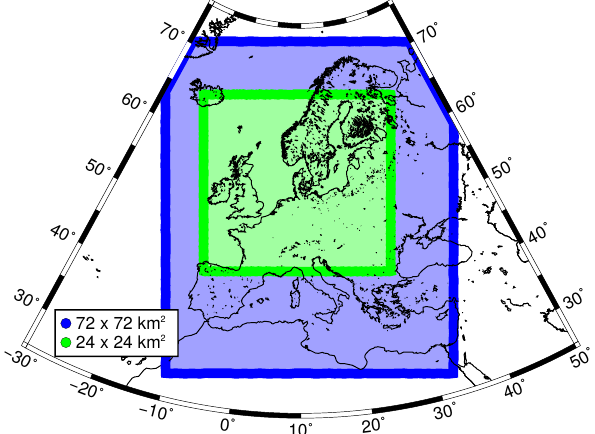
Figure 1. Study region and size of the model grids. The coarse grid (blue) includes Europe and parts of northern Africa. The first nested grid (green) includes northwestern Europe, including the North and Baltic